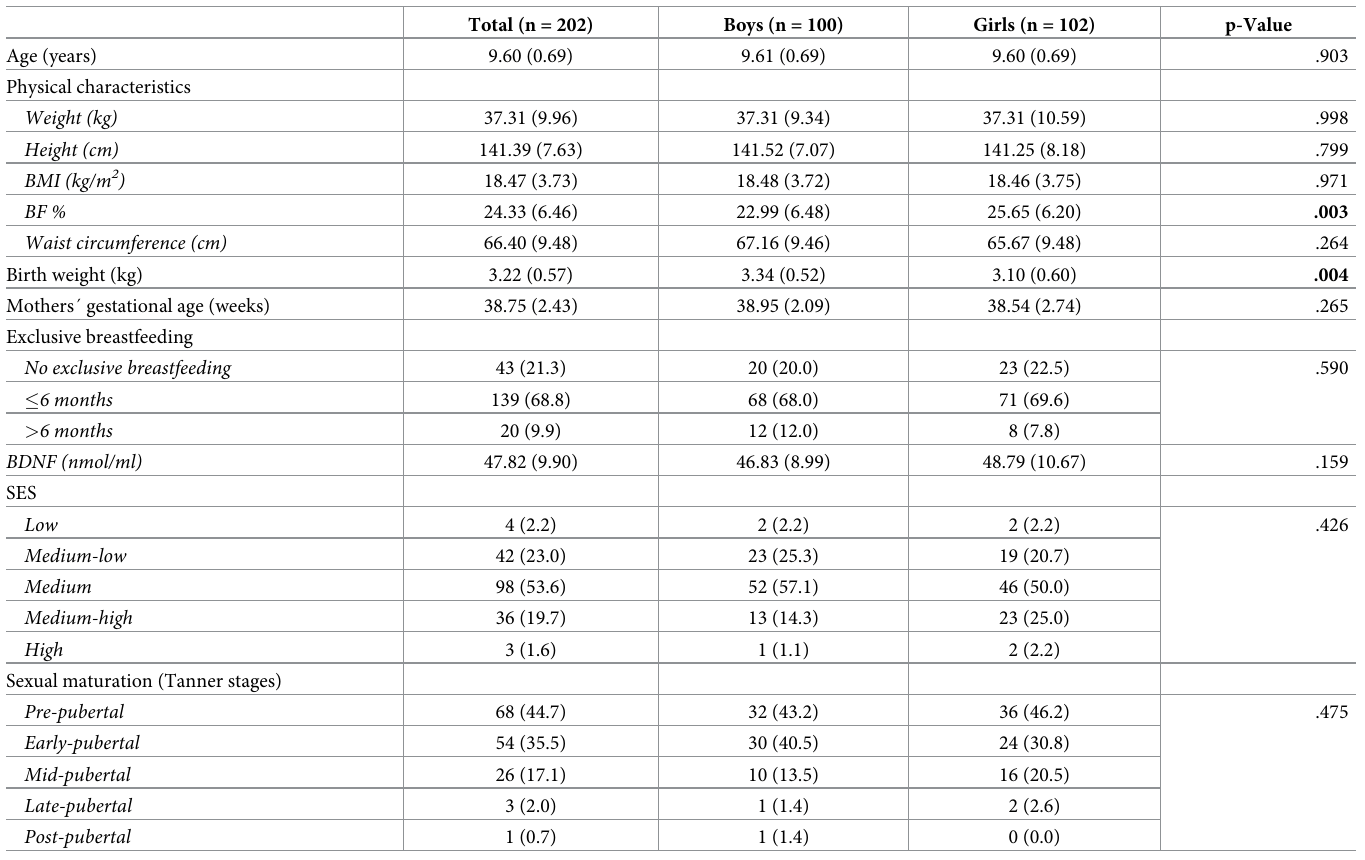
Table 1. Characteristics of the study sample by